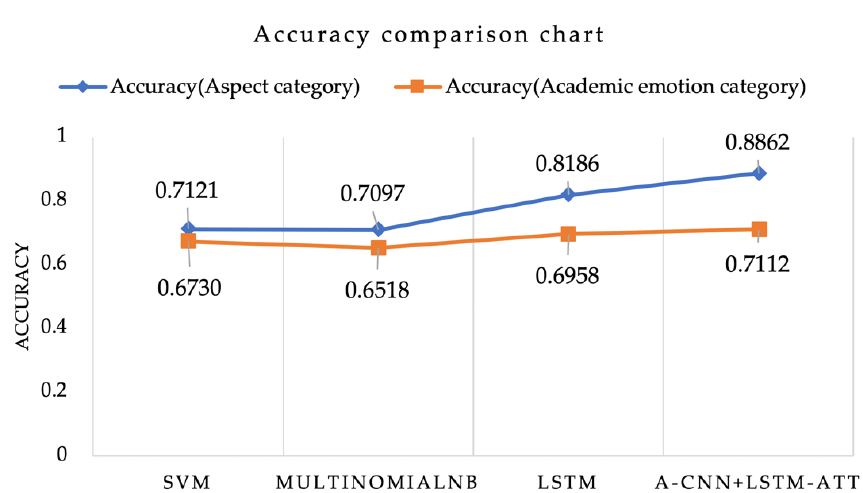
Figure 8. Accuracy comparison of each model.